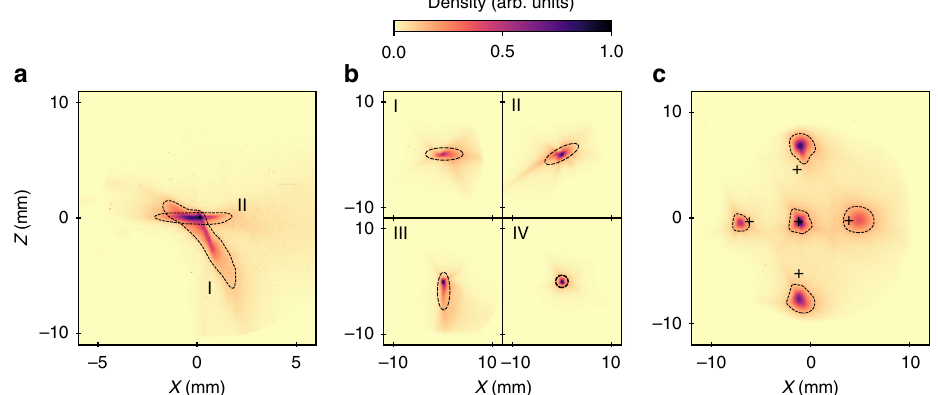
Fig. 5 Beam pointing alignment compensation alignment method. Superimposed images with the appropriate adjustment of the QUAPEVA magnetic axis. a Case of screen in the middle of the chicane where the beam is horizontally dispersed, correction of the vertical dispersion (from I to II). On screen located at the undulator entrance: b initial beam (I), with arti fi cial vertical dispersion introduced (II), with horizontal dispersion corrected (III), with arti fi cial vertical dispersion removed (IV), c beam experimental transverse position control with respect to expected displacements from the model (black